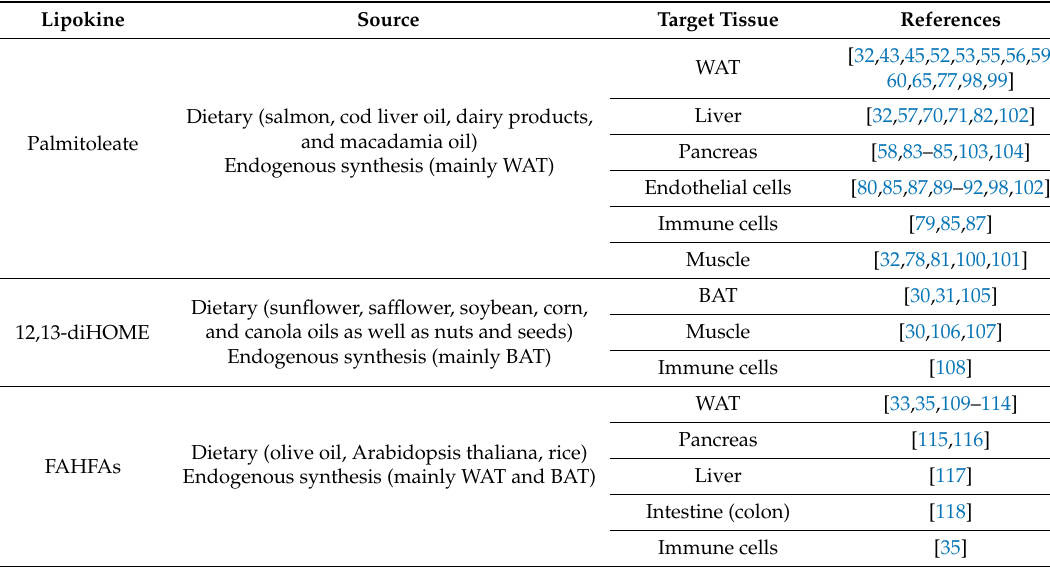
Table 1. Lipokine main sources and tissue